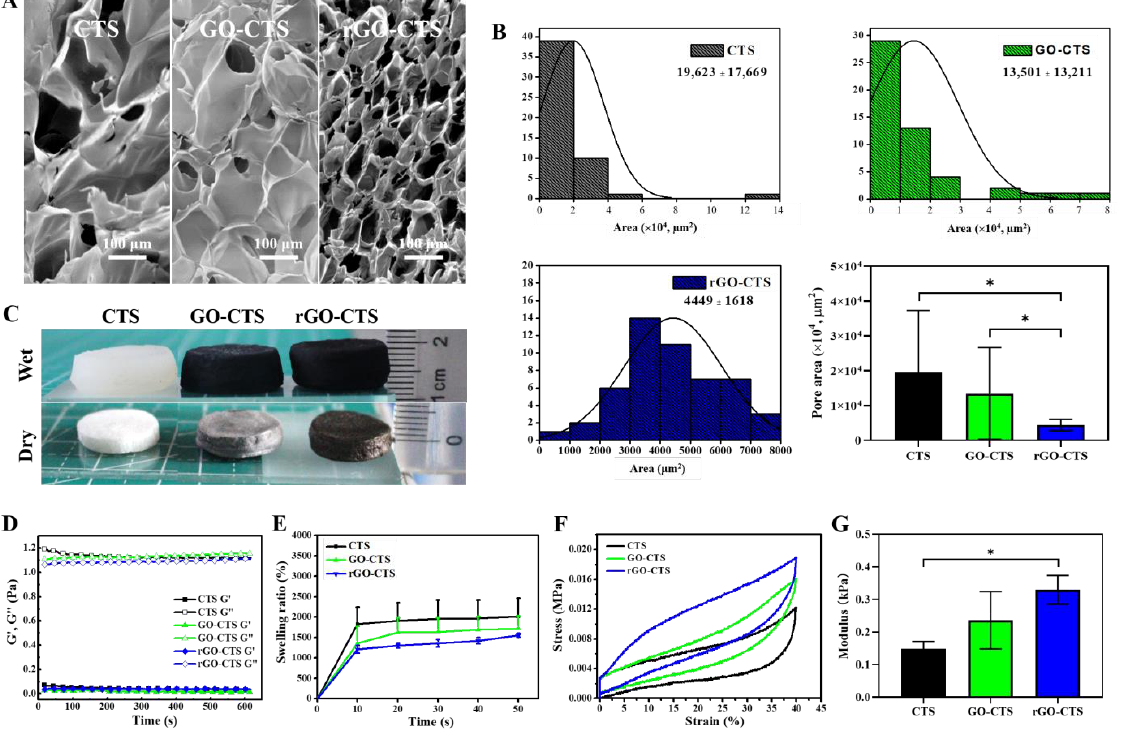
Figure 2. ( A ) SEM images of the CTS, GO-CTS, and rGO-CTS cryogels; ( B ) the pore area of the CTS, GO-CTS, and rGO-CTS cryogels; ( C ) electronic photographs of the CTS, GO-CTS, and rGO-CTS cryogels under dry and wet conditions; ( D ) rheological characterization of the CTS, GO-CTS, and rGO-CTS cryogels; ( E ) the swelling ratio of the CTS, GO-CTS, and rGO-CTS cryogels; ( F ) compressive stress−strain curves of the CTS, GO -CTS, and rGO-CTS cryogels; ( G ) Young’s moduli of the CTS, GO-CTS, and rGO-CTS cryogels. * p < 0.05